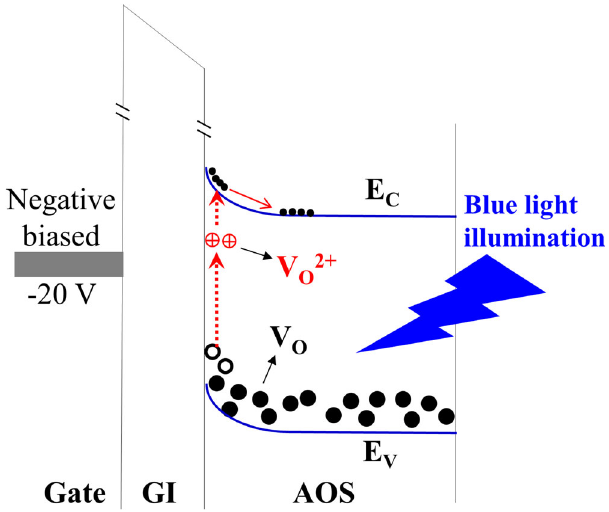
Fig. 6 The origin of NBIS in stability for AOS TFTs. The schematic diagram for generation of Vo 2 + in AOS TFTs under